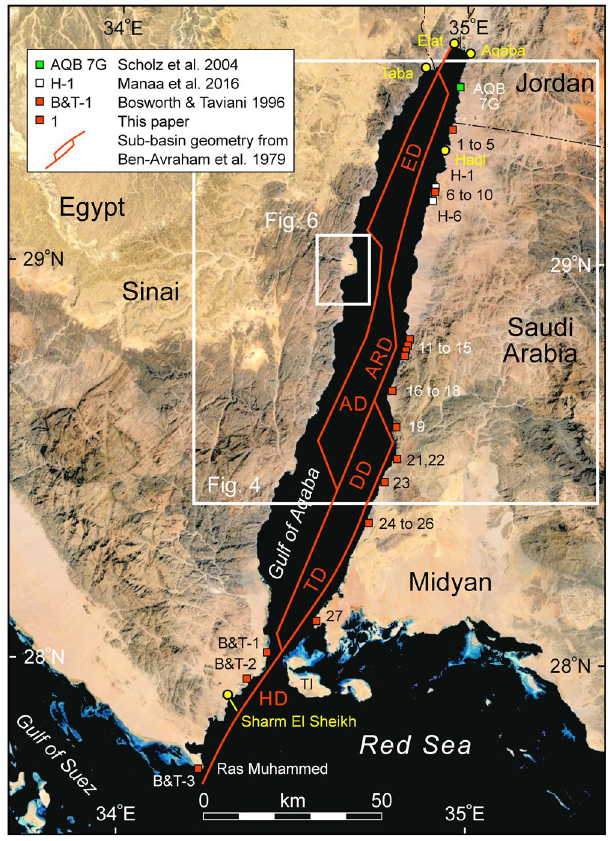
Figure 3. Last interglacial (Marine Isotope Substage 5e) coral terrace and fault kinematic field stations in the Gulf of Aqaba and southern tip of Sinai. Internal sub-basins and main fault geometry are shown with red lines 1 . Location of Figs 4 and 6 are indicated. HD = Hume Deep; TD = Tiran Deep; DD = Dakar Deep; AD = Arnona Deep; ARD = Aragonese Deep; ED = Elat Deep; TI = Tiran Island. Basemap data: Google, SIO, NOAA, US Navy, NGA, GEBCO; Image